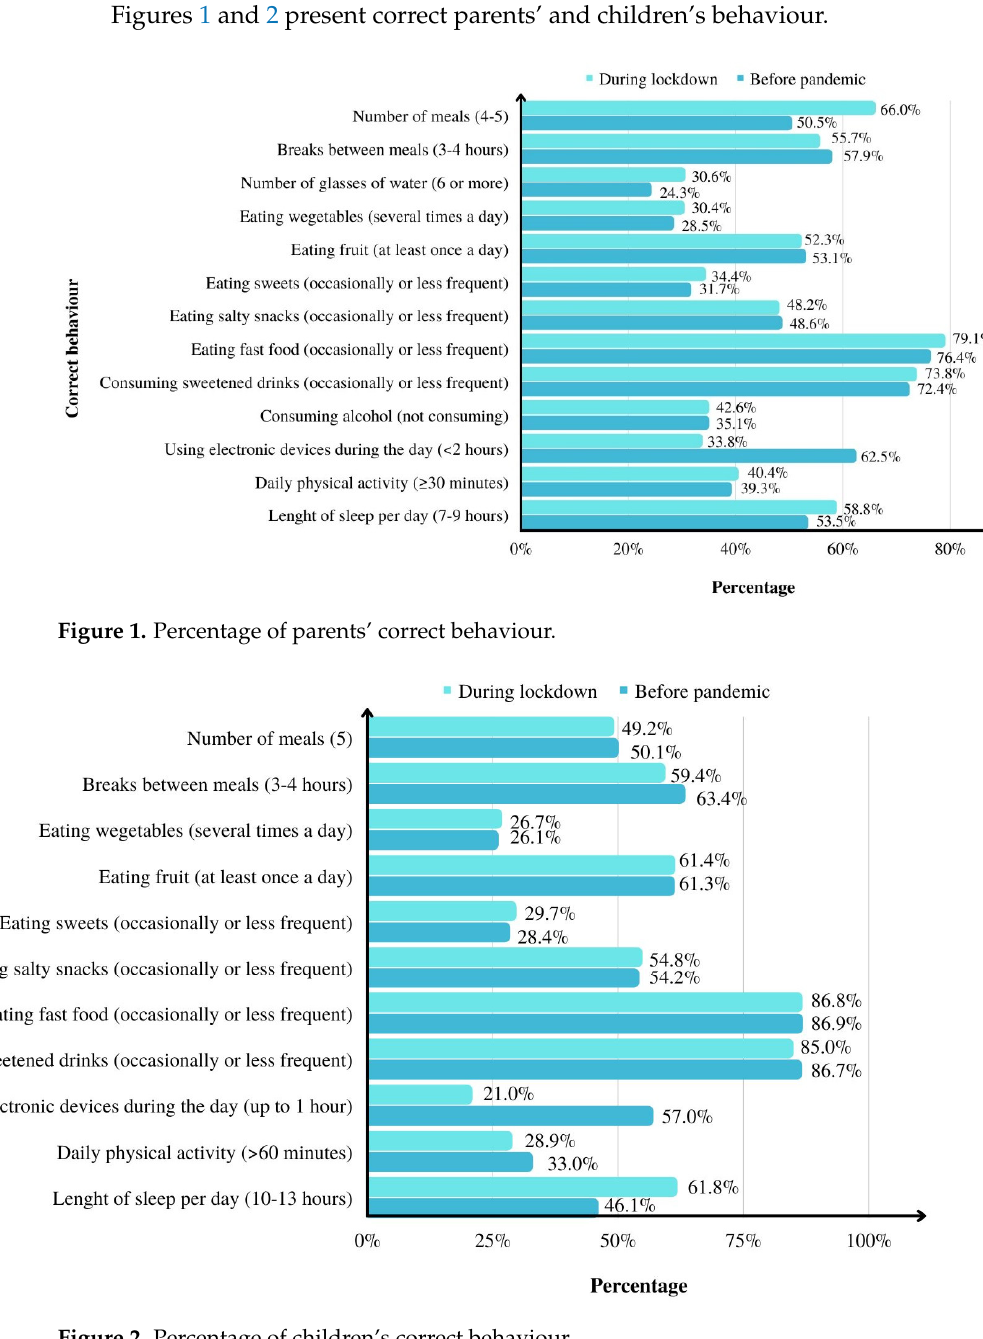
Figure 2. Percentage of children’s correct behaviour.